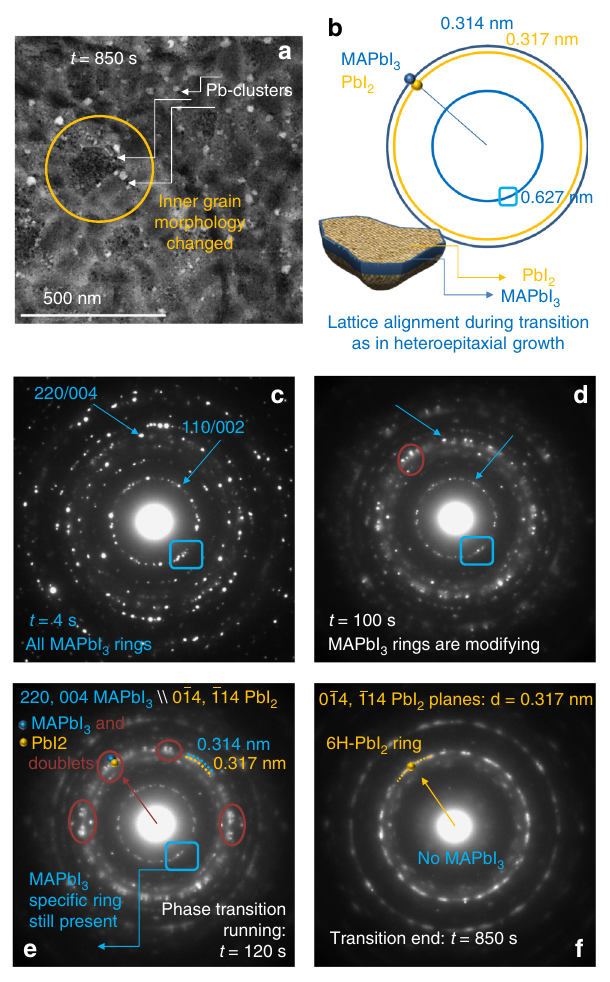
Fig. 2 Second step of MAPbI 3 transition: from MAPbI 3 to fragmented 6H- PbI 2 . The layer thickness is 40 nm. a Plan-view TEM image taken in the same region as in Fig. 1 after 850 s of electron exposure. At this time, the transition of MAPbI 3 to PbI 2 is completed. b Schematic on the nano- fragmentation of a single MAPbI 3 grain during its transformation: nano-PbI 2 grains are structurally connected to the mother perovskite grain as unveiled by the alignment of the diffracted spots. From c – f ED patterns (EDPs) tracing the evolution of the phase transition from MAPbI 3 to PbI 2 (volatile species are pumped away). The sequence is taken at fi xed sample position over an area comparable to the image size in a . For each ED the acquisition time was 4s. Resulting main coupled interspacing distances of the two phases are summarised in b and labelled in light blue for MAPbI 3 and dark yellow for 6H-PbI 2 . The speci fi c ring at d = 0.627 nm univocally identi fi es the MAPbI 3 layer: it is used as marker to trace its full transformation to PbI 2 . The spots at d = 0.317 nm are diagnostic of the 6H-PbI 2 polymorphism. MAPbI 3 -PbI 2 doublets, some of them circled in dark orange in fi gures d , e , start forming after ~100 s ( d ): they are better resolved after 120 s ( e ). The blue boxes in c – e indicate the diagnostic ring of MAPbI 3 : once fully lost, the transition is completed ( f